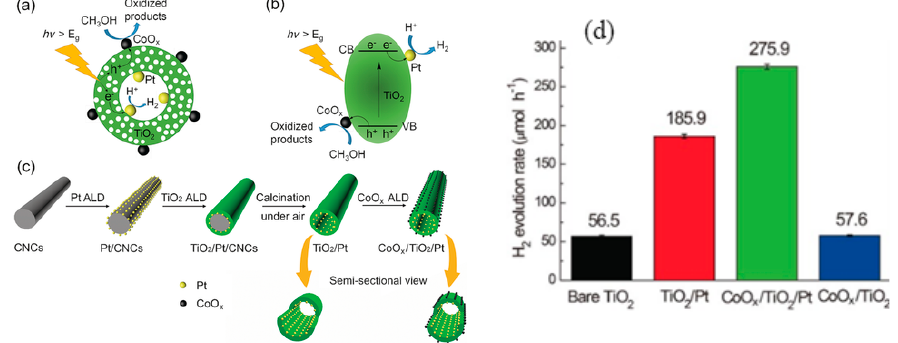
Figure 9. ( a , b ) The mechanism of photocatalytic hydrogen production by CoOx/TiO 2 /Pt. ( c ) Synthetic process of CoO x /TiO 2 /Pt by atomic layer deposition (ALD). ( d ) Photocatalytic hydrogen production of different photocatalysts in a 15 vol% methanol–water solution under UV. Reprinted with permission from [153].